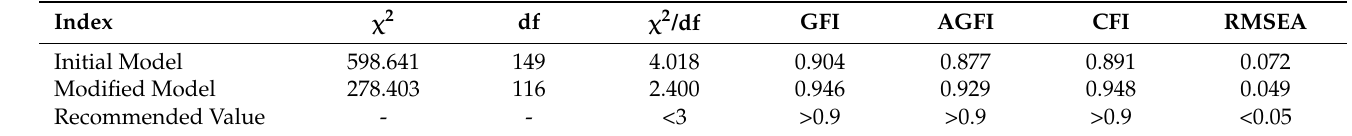
Table 6. Results of the model fit